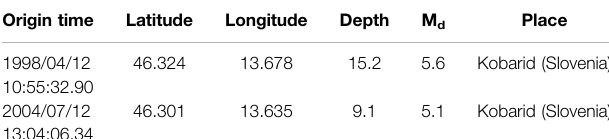
variation of seismicity within each sub-region, we consider the TABLE 1 | The three selected Friuli-Venezia Giulia sub-regions data. following parameters as a function of time: the inter-event times τ , Sub- OGS catalog estimates Global values (Nekrasova the cumulative strain release Ʃ , the coef fi cients A, B, C of the USLE region 1995/1/1 – 2019/3/21 and Kossobokov, 2019) and USLE control parameter η . The empirical cumulative N eq , distribution functions of inter-event time τ and Benioff strain M ≥ release Σ for the entire FVG Region and its three sub-regions 2.0 are presented in Figure 2 . Each distribution can be characterized by the c -values of the best fi t trend. Speci fi cally, the c -values of the natural exponential trend fi t for τ p( > t ) (cid:2) α exp ( − γ τ ) are estimated as 0.48 ( R 2 (cid:2) 0.96), 0.064 ( R 2 (cid:2) 0.98), 0.048 ( R 2 (cid:2) 0.88), and 0.065 ( R 2 (cid:2) 0.83) in FVG, A1, A2, and A3, respectively. Actually, the best trend fi t of τ in A3 sub-region appears to be logarithmic: p( > t ) (cid:2) − 0.091 ln( τ ) + 0.41 ( R 2 (cid:2) 0.98). The c -values for the best power law trend fi t for Σ , p( > Σ ) (cid:2) αΣ − γ , are estimated as 1.23, 1.598, 1.407, TABLE 2 | The two largest earthquakes in Friuli-Venezia Giulia region from 1995 1.586 in FVG, A1, A2, and A3, respectively ( R 2 (cid:2) 0.98 for all the four to 2019. cases). Log Σ is a linear function of magnitude M, therefore the distribution of Benioff strain release ( Figure 2B ) differs from Origin time Latitude Longitude Depth M d Gutenberg-Richter relation in the abscissa scale only. As is evident from Σ de fi nition, which is proportional to 10 0.75M , the c -values for Σ are well in agreement with the Gutenberg-Richter the b-values ( Table 1 ).